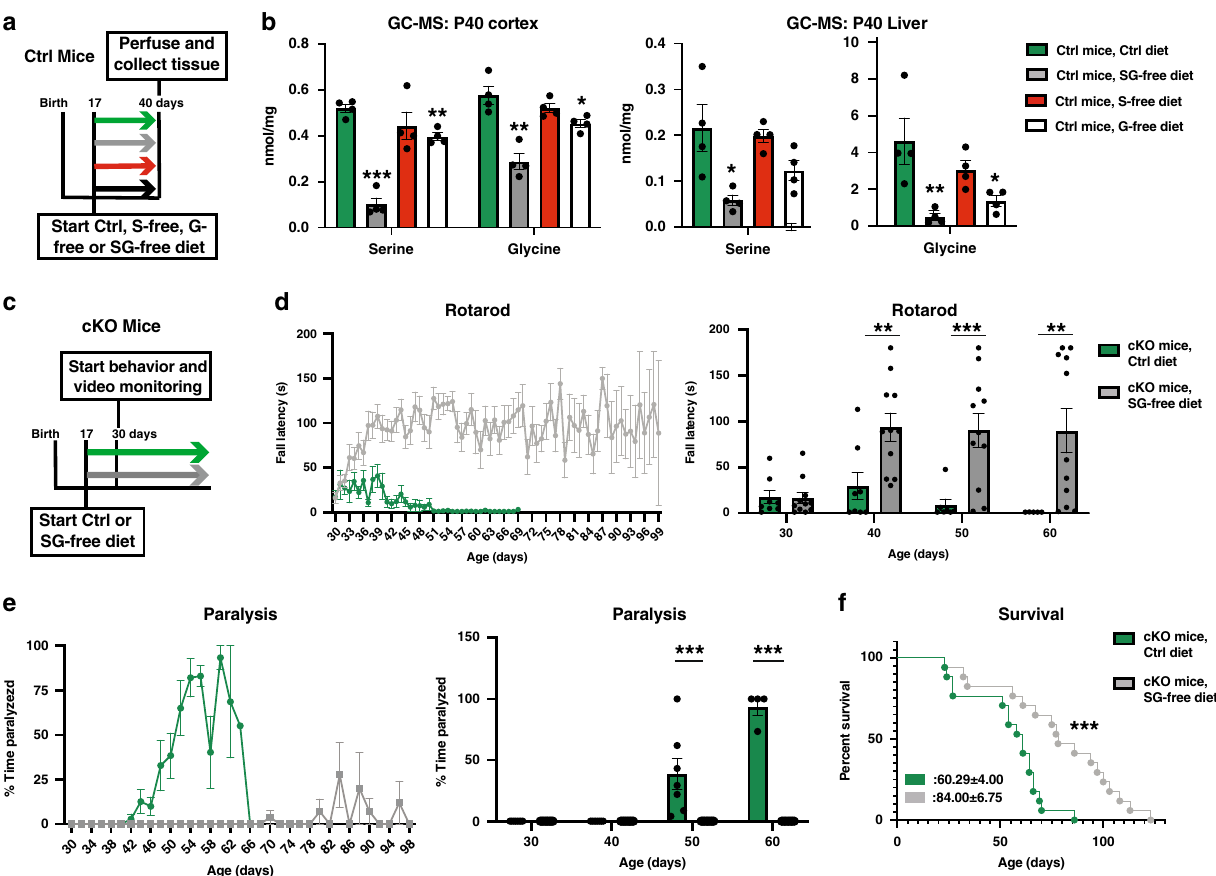
Fig. 6 Serine- and glycine-free diet reverses motor paralysis and ataxia in conditional α 2-Na/K ATPase knockout mice. a , b Sex-matched littermate f/f or f/ + control (Ctrl) mice were weaned at P17 onto one of the following diets: Ctrl, serine-free (S-free), glycine-free (G-free), or serine- and glycine-free (SG-free). The cerebral cortex and liver collected from P40 perfused Ctrl mice on Ctrl, S-free, G-free, and SG-free food were subjected to GC – MS for serine and glycine levels ( b ). The SG-free diet reduced the levels of serine and glycine substantially in the cerebral cortex and liver in Ctrl mice. Data are presented as mean ± s.e.m. * P < 0.05, ** P < 0.01, *** P < 0.001 (two-tailed t test, n = 4 mice per group). c – e Sex-matched littermate conditional α 2-Na/K ATPase knockout (cKO) mice were weaned onto Ctrl or SG-free diet at P17 and weighed daily thereafter. Daily rotarod analyses and every other day monitoring for motor paralysis of mice was begun at P30. Left: mean latency to fall on constant velocity rotarod task for cKO mice on Ctrl or SG-free diet ( d ). Data are presented as mean ± s.e.m. ( n = 11 mice per group starting at P17). Right: a subset of data from left side shown for clarity. Data are presented as mean ± s.e.m. ** P < 0.01, *** P < 0.001 (two-way ANOVA followed by Fisher ’ s LSD post hoc test, n = 11 mice per group starting at P17 — 4 males, 7 females). Left: percentage of time paralyzed for sex-matched littermate conditional α 2-Na/K ATPase knockout mice (cKO) on Ctrl or SG-free food ( e ). Data are presented as mean ± s.e.m. *** P < 0.001 (two-tailed t test, n = 11 mice per group starting at P17). Right: a subset of data from left side shown for clarity. The serine- and glycine-free diet reversed transient motor paralysis in conditional α 2-Na/K ATPase knockout mice. Data are presented as mean ± s.e.m. *** P < 0.001 (two-way ANOVA followed by Fisher ’ s LSD post hoc test, n = 11 mice per group starting at P17 — 4 males, 7 females). f Survival was modestly, albeit signi fi cantly, extended in cKO mice on SG-free food compared to Ctrl food. *** P < 0.001 (log-rank (Mantel – Cox) test, n = 17 mice per group — 6 males, 11 females, P =